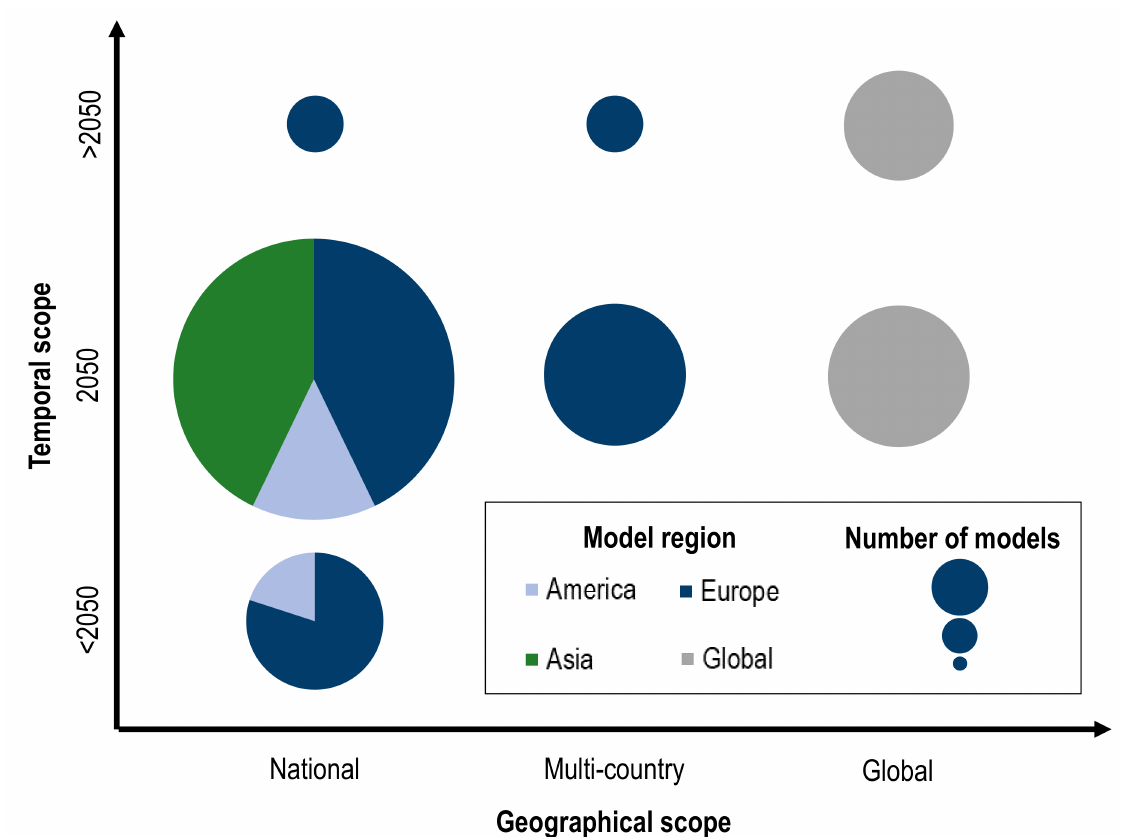
Figure 3. Temporal and geographical scope of the investigated transport sector models underlining the focus on national analyses up through the year